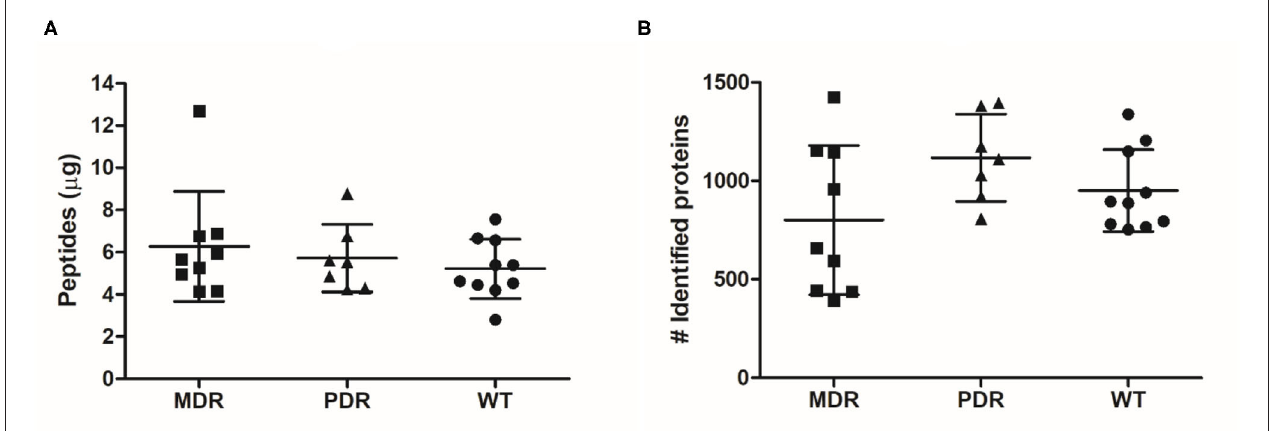
FIGURE 1 | Graph distribution of purified peptides and identified proteins. (A) After the shaving procedure, a mean of 6.27 µ g ( ± 2.60 standard deviation), 5.72 µ g ( ± 1.60) and 5.21 µ g ( ± 1.40) of peptides in the MDR, PDR, and WT samples, respectively, were purified. (B) By nLC–ESI–MS/MS, we identified a mean of 801 ( ± 379), 1,117 ( ± 221), and 950 ( ± 208) proteins were identified in the MDR, PDR, and WT groups, respectively.